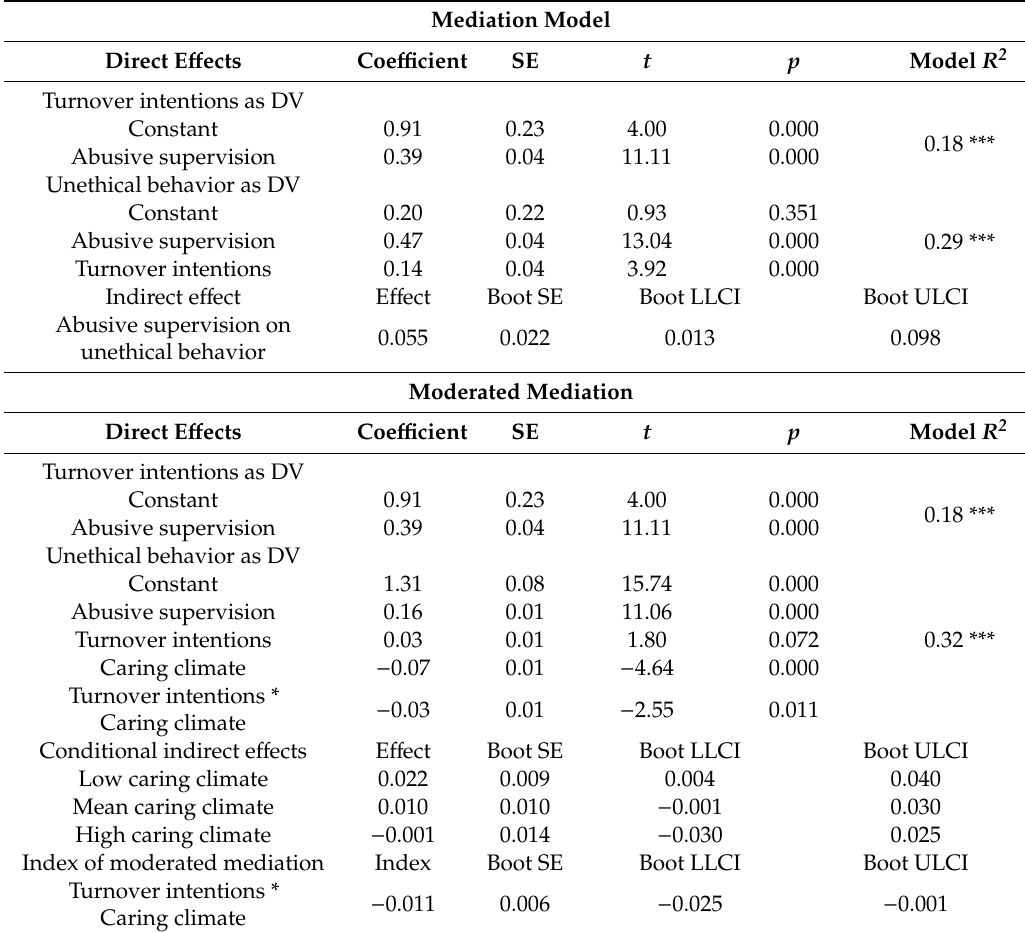
Table 3. Mediation and moderated mediation